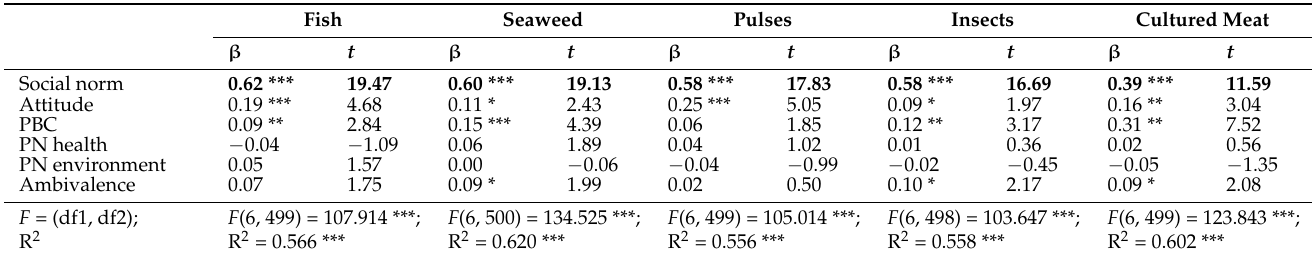
Table 3. Hierarchical regression analyses for 2019 with drivers as the independent variables and intention as the dependent variable.